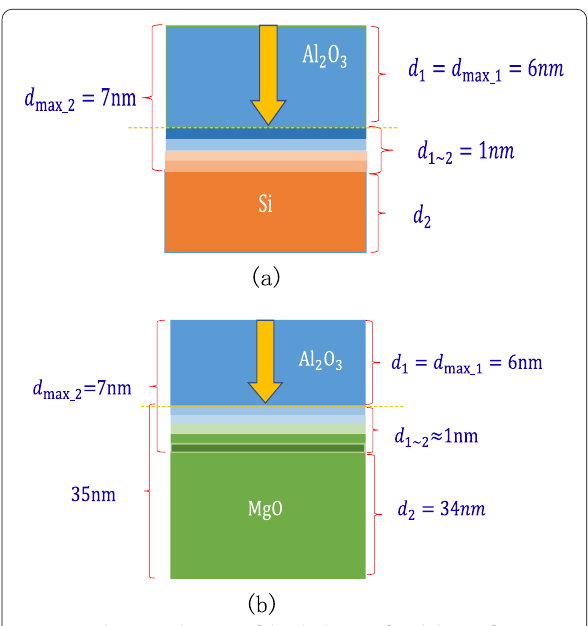
Fig. 19 Schematic diagram of the thickness of each layer of a multilayer structure, a shows the thickness of Al 2 O 3 (on the silicon wafer, grow 7 nm-Al 2 O 3 ), b shows the thickness of MgO/Al 2 O 3 (on the silicon wafer, grow 20 nm-MgO, and then grow 7 nm-Al 2 O 3